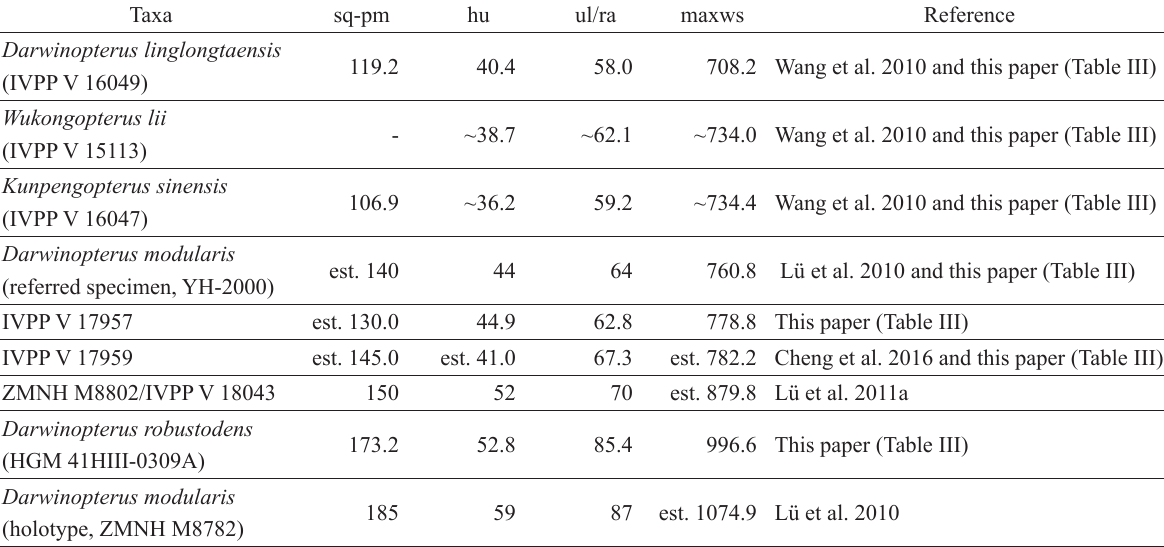
Measurements of the length of skull, humerus and ulna of the Wukongopteridae, from the smallest to the largest individual based on wingspan (in